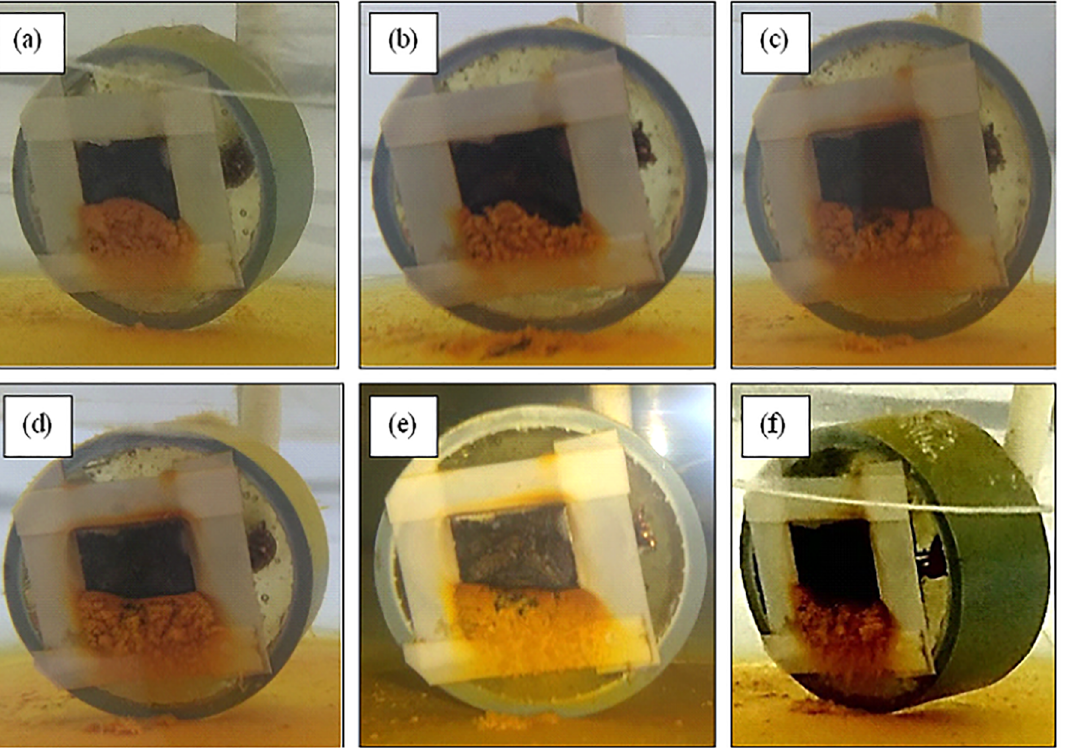
Figure 4. Evolution of the deposit layer on the surface of ASTM A131 grade A36 carbon steel. (a) after 24 hours; (b) after 48h; (c) after 1 week; (d) after 2 weeks; (e) after 3 weeks; (f) after 4